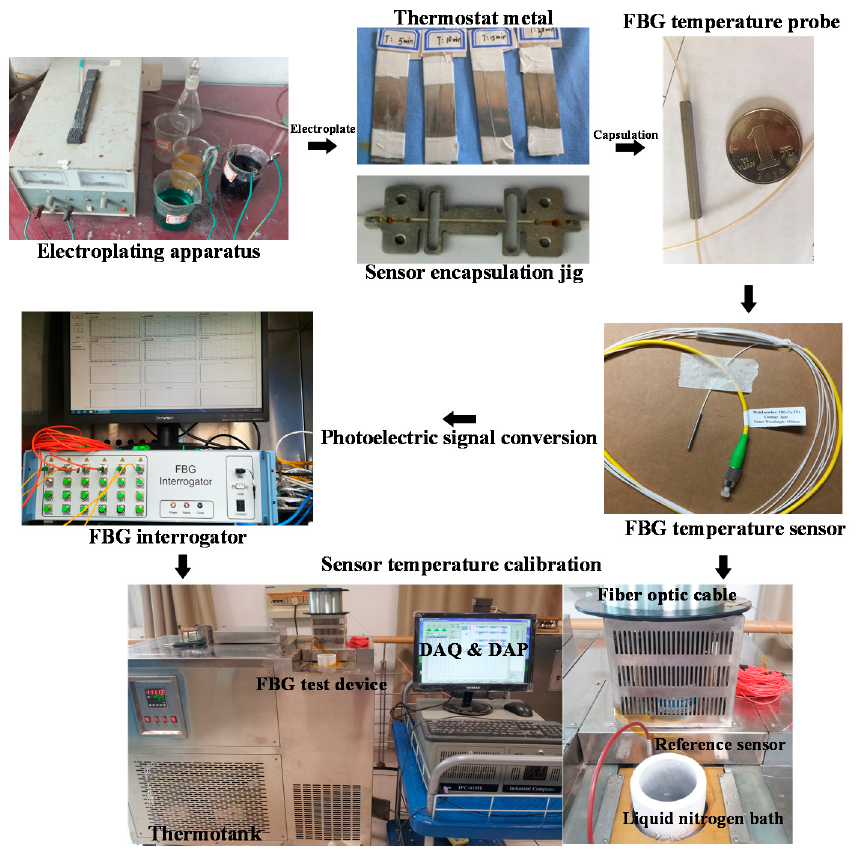
Figure 2. FBG plating, encapsulation, and temperature linearity